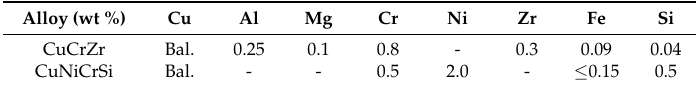
Table 1. The chemical compositions of the CuCrZr alloy and CuNiCrSi alloy.